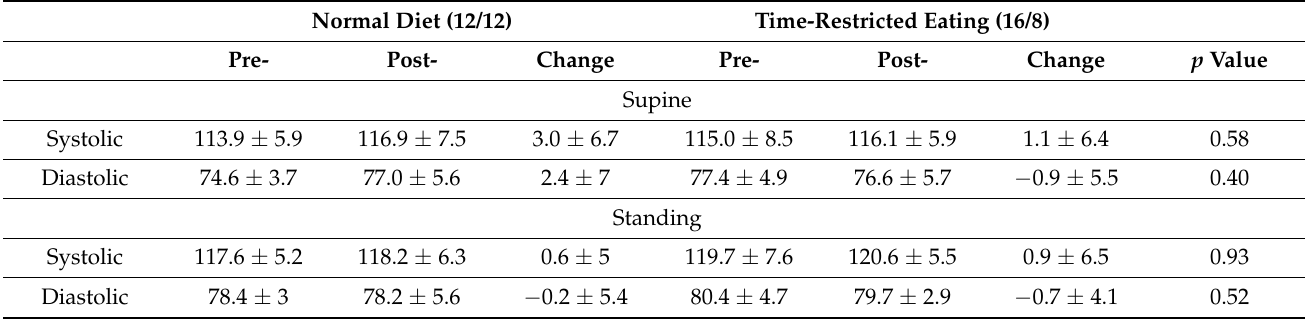
Table 7. Resting Supine and Standing Blood Pressure 1 .